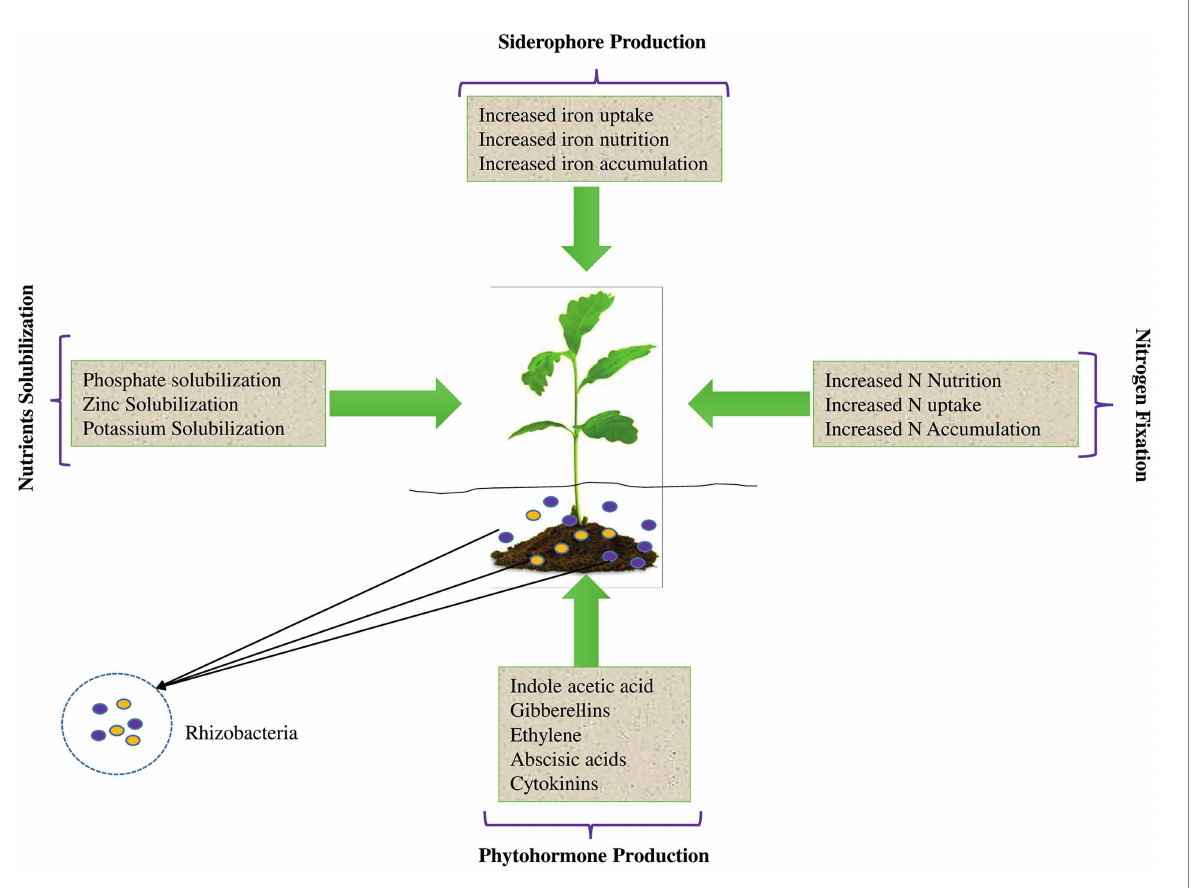
FIGURE 2 A simulation of the various functions of biofertilizers in plant growth